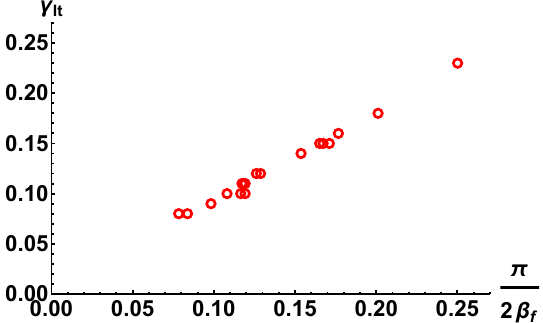
Figure 10. The exponent (cid:13) It as a function of (cid:13) conf = (cid:25)= (2 (cid:12) f ). (cid:13) ret is exactly equal to (cid:13) It as we can see from table 1 so (cid:13) ret is not plotted here.